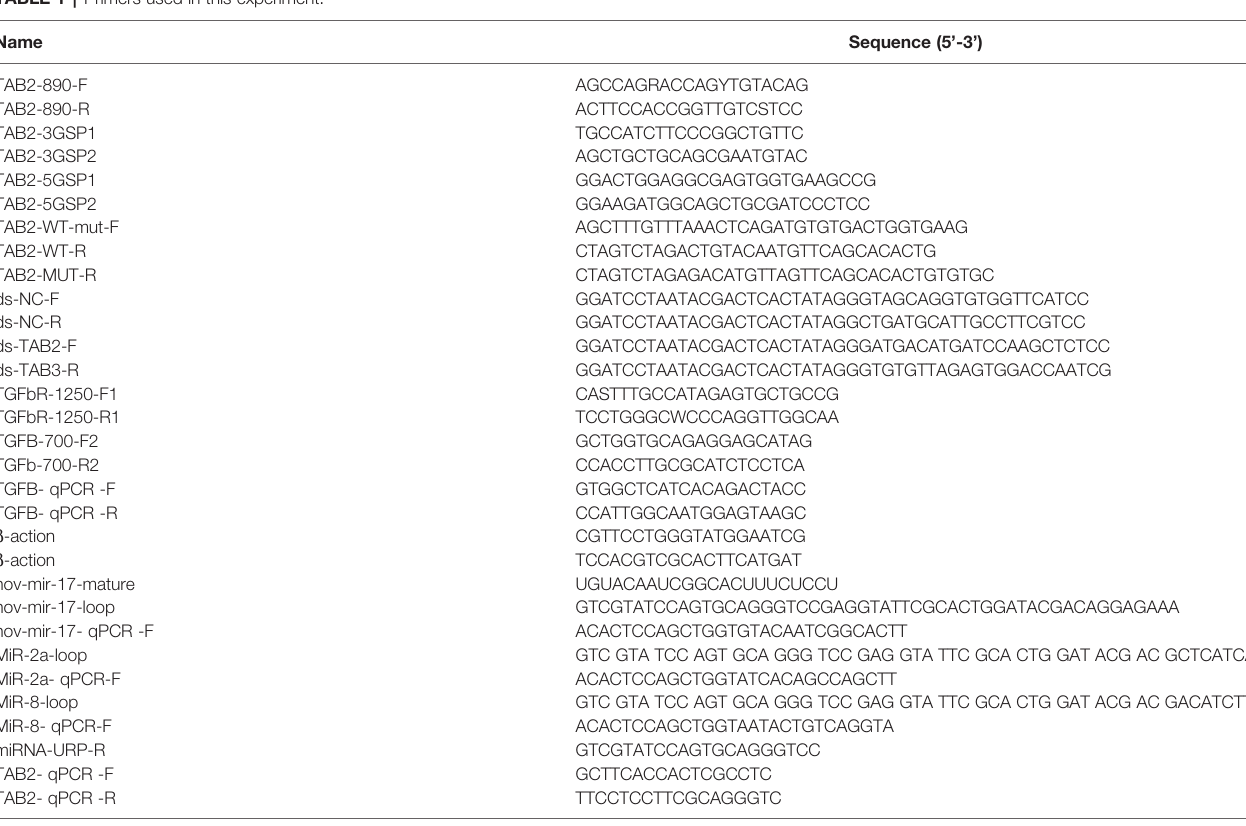
TABLE 1 | Primers used in this